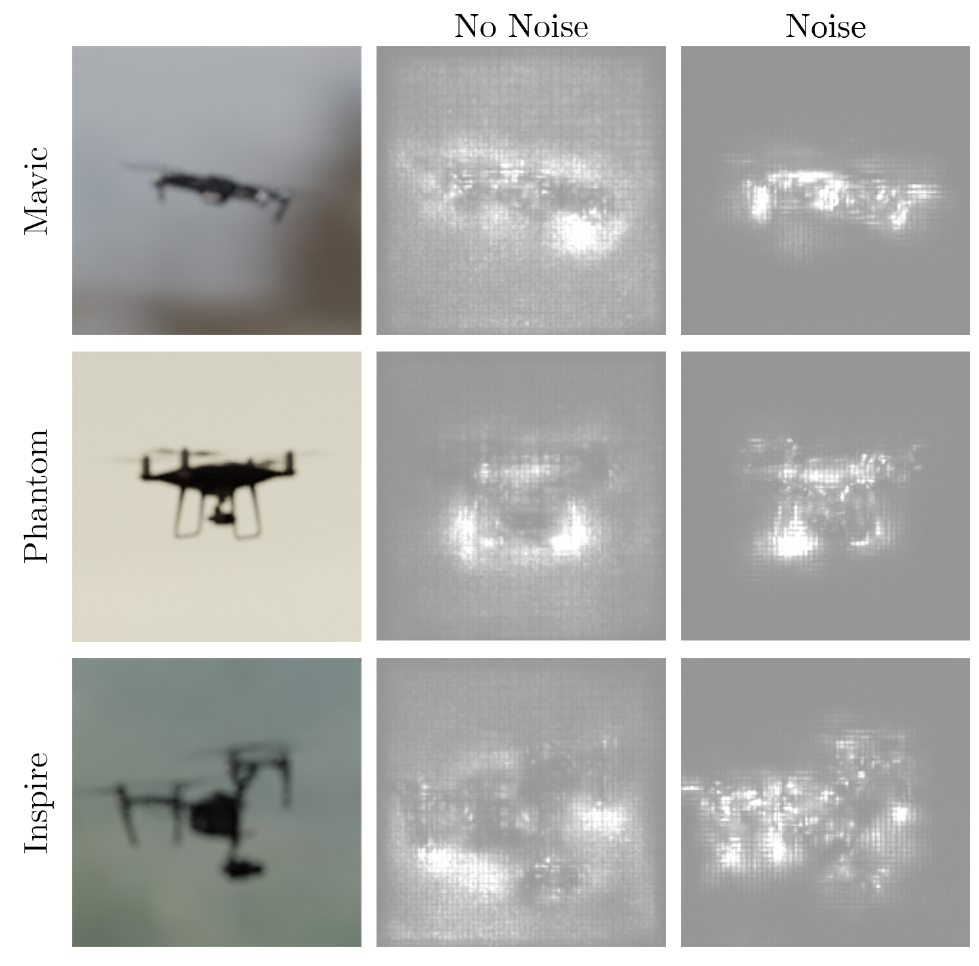
Figure 3. SmoothGrad visualizations of the neural network models trained on a dataset with and without Gaussian noise. The drone image input into the network is shown in the left column. The middle column shows the SmoothGrad visualizations of the CNN trained on a synthetic dataset with no Gaussian noise added. The column on the right shows the SmoothGrad visualizations of the CNN trained on a synthetic dataset with Gaussian noise added. Qualitatively, it appears that, by adding Gaussian noise, more pixels in the area covering the drone are activated. In contrast, when noise is not added, more pixels in the background are